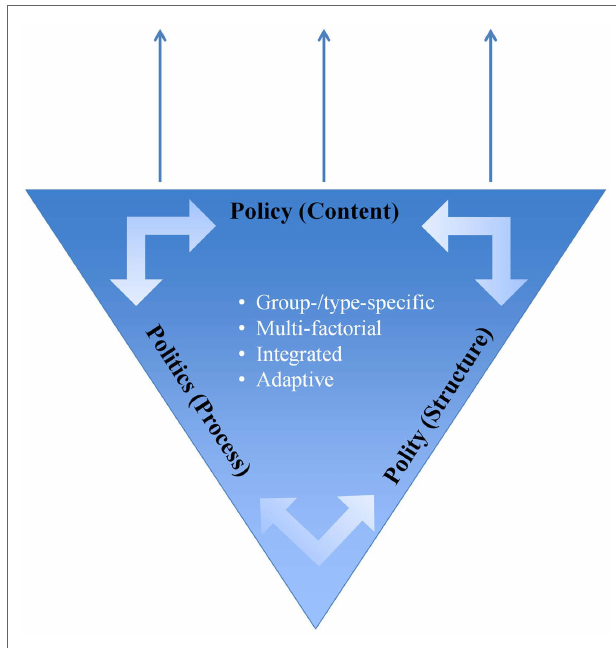
FiGUre 5 | Governance of changing eCB